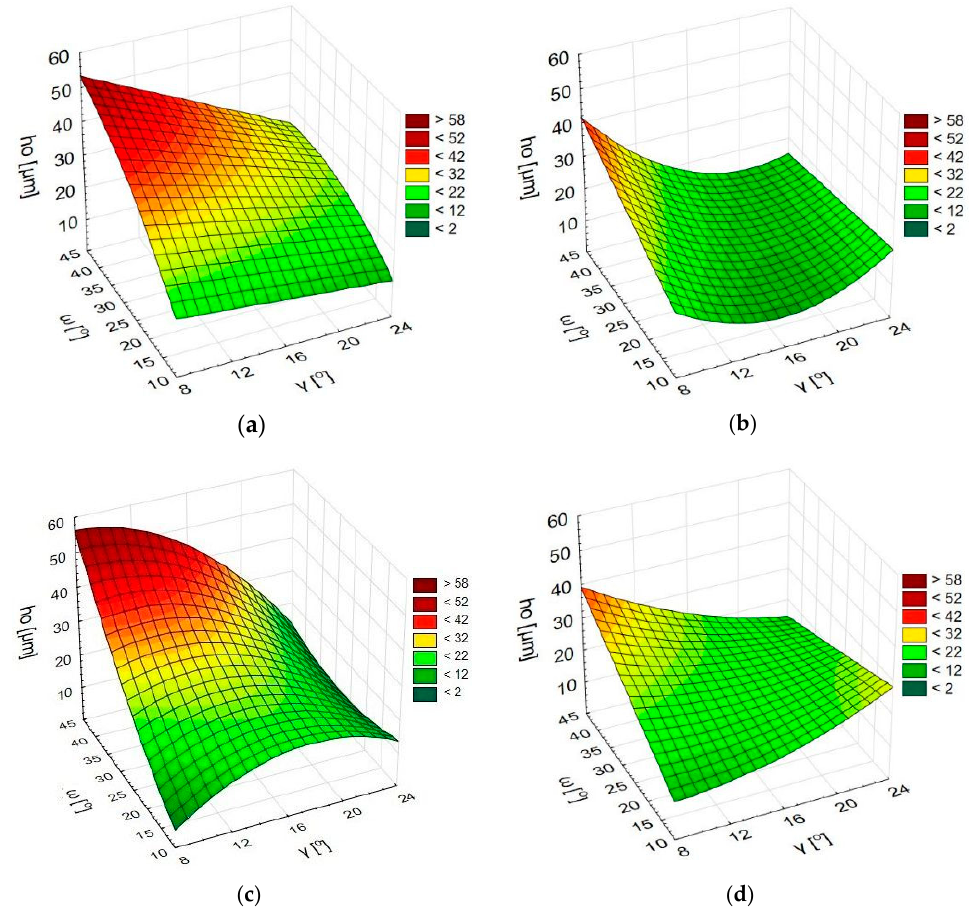
Figure 8. The height of burr h o as a function of the angles ω and γ ; L/R process ( a ), R/L process ( b ), L/L process ( c ), R/R process ( d ).